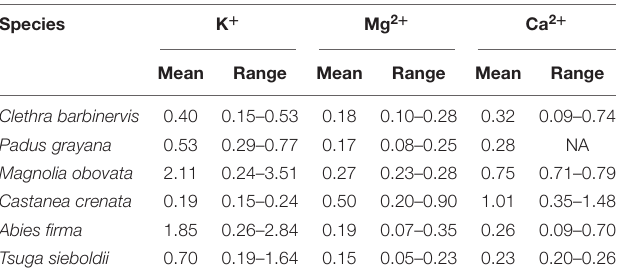
TABLE 1 | Leaching rates ( µ mol L − 1 h − 1 ) of K + , Mg 2 + , and Ca 2 + by species, estimated as the slope of a linear regression relating concentration and time of saturation during the soaking experiment.